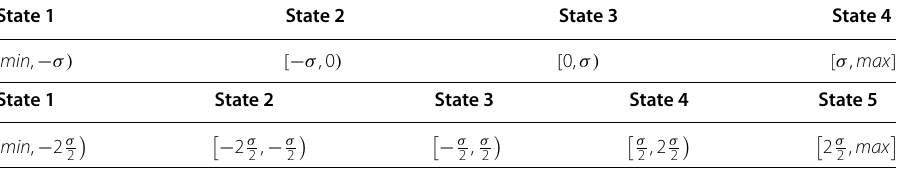
Table 1 Examples of the sigma approach with odd and even numbers of states State